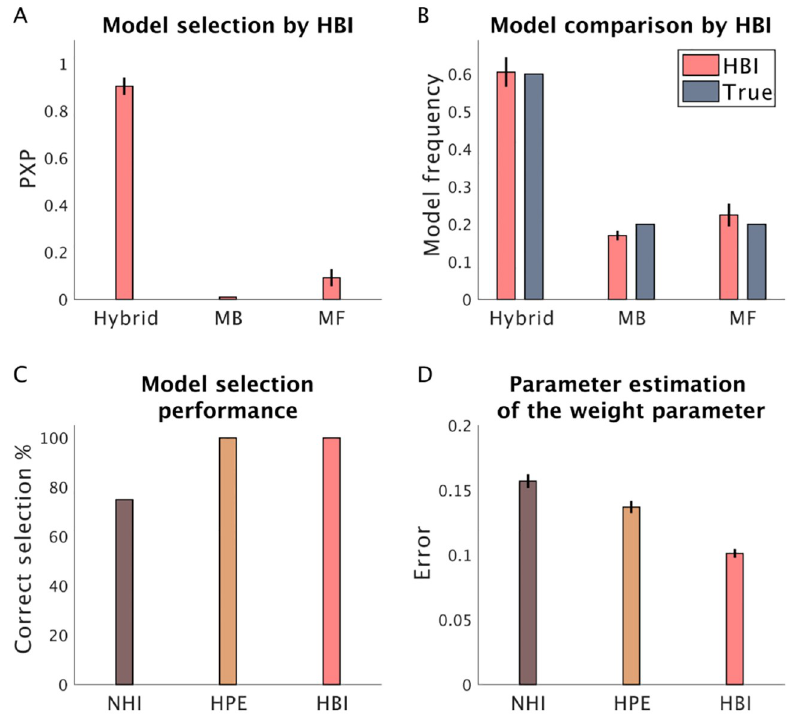
Fig 9. Performance of the HBI in the two-step Markov decision task. 30, 10 and 10 artificial subjects have been generated using the hybrid, the model-based (MB) and the model-free (MF) models, respectively. A) Model selection by HBI using protected exceedance probabilities (PXP). B) Model frequencies estimated by the HBI. C) Model selection performance (at 50%) of NHI, HPE, and HBI. D) Error in estimating the critical weight parameter of the hybrid model at the individual level. HBI shows less error than other methods in all simulations. In all plots, error-bars are standard errors of the mean obtained across 20 simulations.